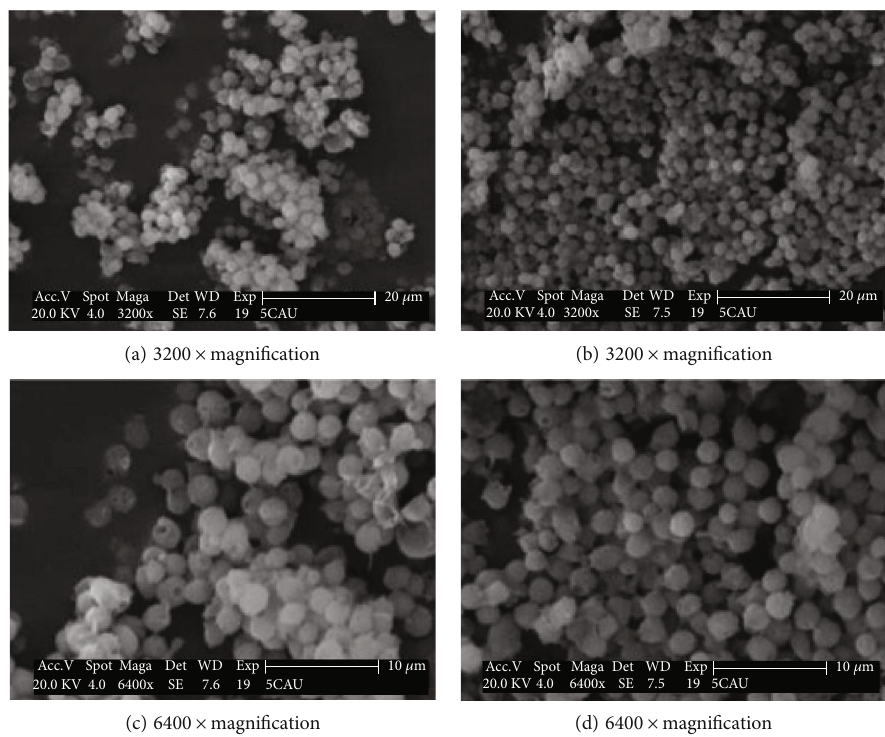
Figure 32: SEM micrographs of chitosan – gelatin microcapsules produced by mechanical agitation emulsi fi cation (a, c) and shearing emulsi fi cation (b, d)